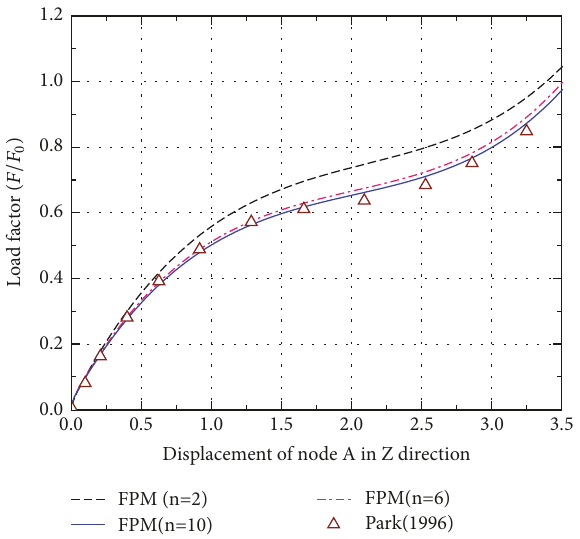
Figure 14: Load-displacement curve of node